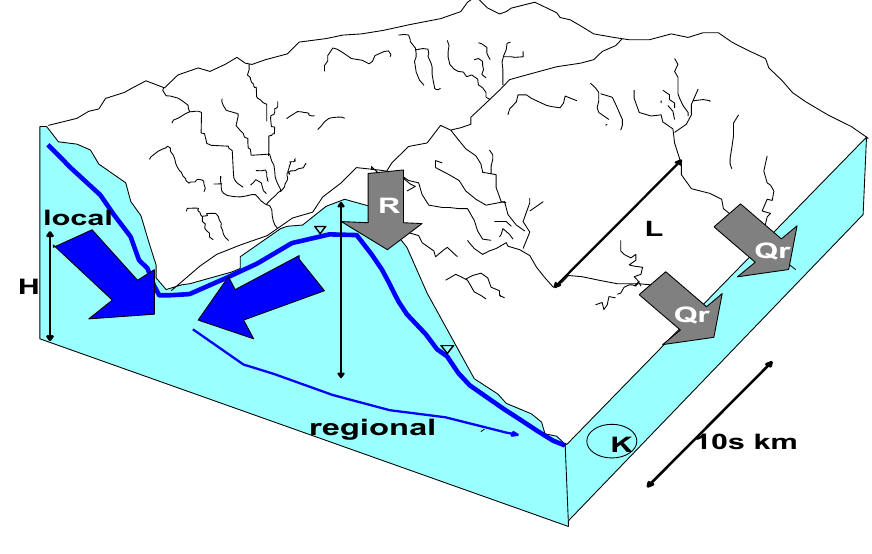
Fig. 1 A schematic diagram depicting a topography-con- trolled water table ( Modified from Gleeson et al. 2011)